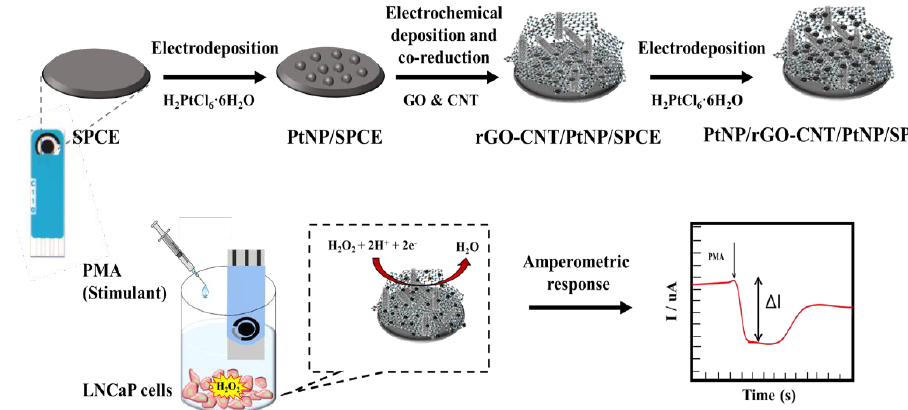
Figure 1. Schematic illustration of the fabrication process and sensing protocol of the PtNP/rGO– CNT/PtNP/SPCE sensor for detection of H 2 O 2 released from live LNCaP